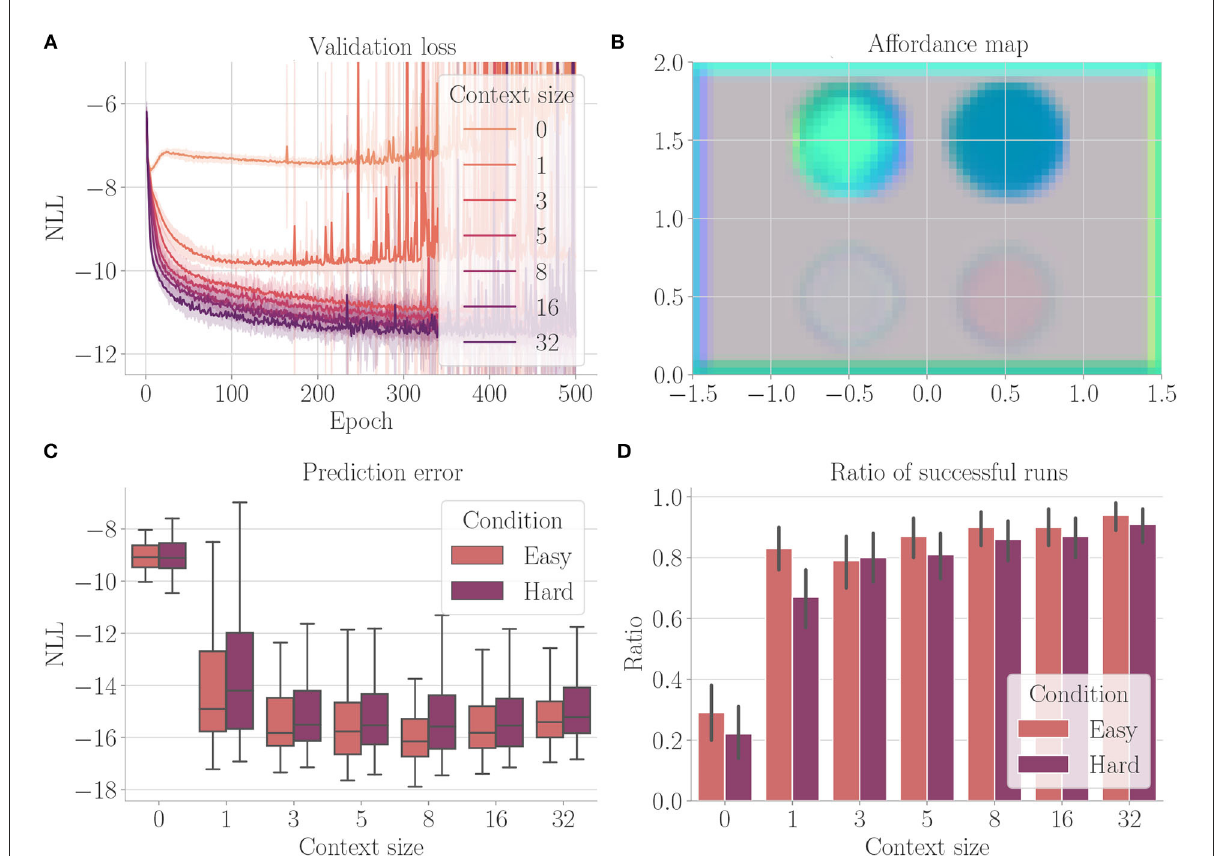
FIGURE11 Results from Experiment V–Disentanglement (Section 4.7). For each setting, the results are aggregated over 25 differently initialized models which each performed 4 goal-directed control runs for 200 time steps. The box plot shows the medians (horizontal bars), quartiles (boxes), and minima and maxima (whiskers). Data points outside of the range defined by extending the quartiles by 1.5 times the interquartile range in both directions are ignored. The bar plot shows the means, where black lines represent the SDs. “Easy” refers to the condition where obstacles and terrains do not overlap, “Hard” refers to the condition where, force fields can overlap with each other, obstacles, and fog terrains. (A) Validation loss during training. It is the negative log-likelihood of the actual change in position in the transition model’s predicted probability distribution. Shaded areas represent SDs. (B) Exemplary affordance map for context size 8 . This environment contains all four properties (obstacle in the upper left, for terrains in the upper right, force field pointing downward in the lower left, and force field pointing upward in the lower right). It was not used during goal-directed control. To generate this map, we probed the environmental map at every sensible location, applied the vision model to each output, performed dimensionality reduction to 3 via PCA, and interpreted the results as RGB values. (C) Prediction error during goal-directed control. It is the negative log-likelihood of the actual change in position in the transition model’s predicted probability distribution. (D) The ratio of successful runs. A run was successful if the agent was closer to the target than 0.1 units in at least one time step and did not touch fog in any time